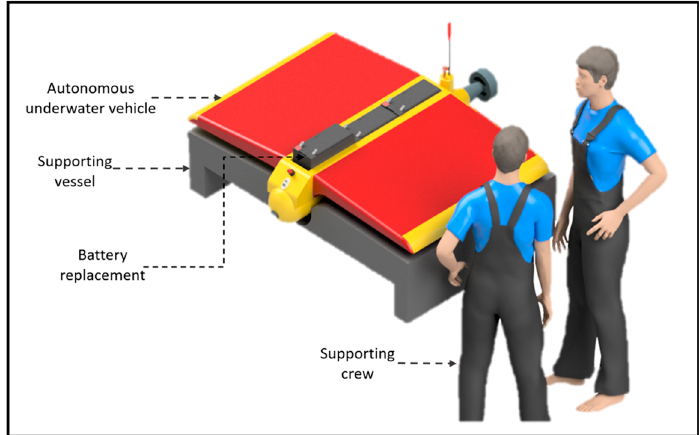
Figure 8. Model of battery replacement approach of Bluefin-AUV.